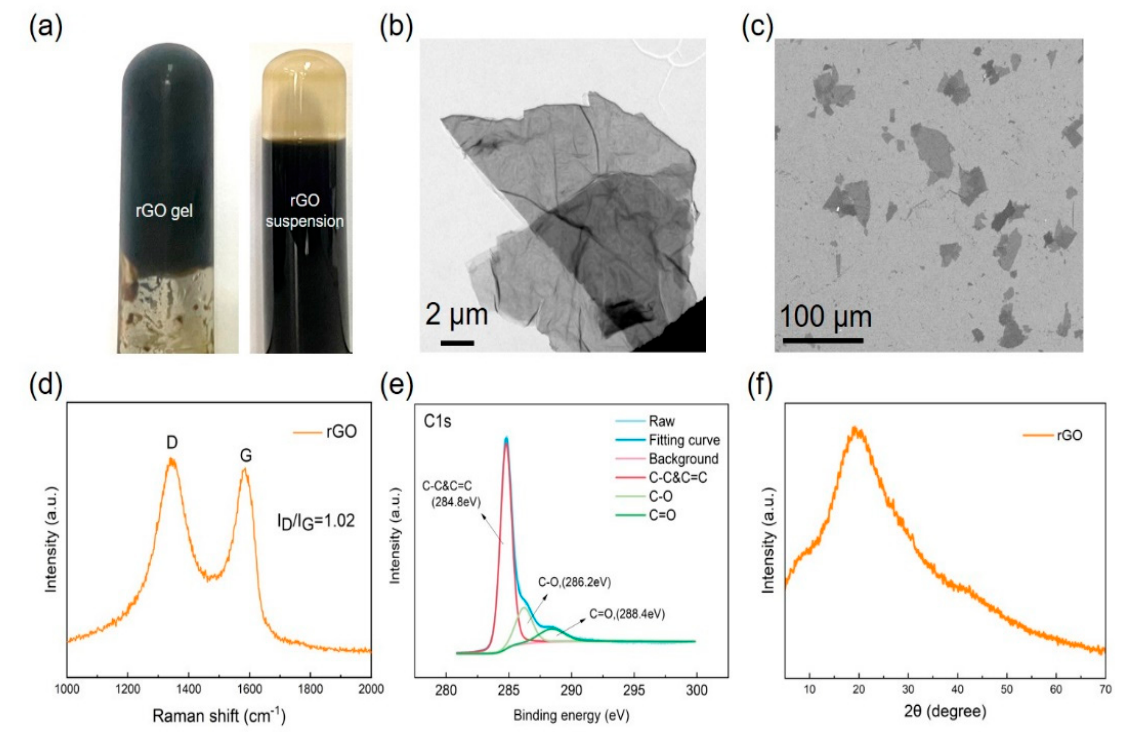
Figure 3. Basic characterizations of rGO. ( a ) Picture of the freshly obtained rGO. Left: rGO gel, right: rGO suspension after 12,000 r min − 1 . ( b ) TEM, ( c ) SEM of rGO from different magnifications. ( d ) Raman spectra of rGO. ( e ) C 1s XPS spectra of as-prepared rGO. ( f ) XRD patterns of rGO.